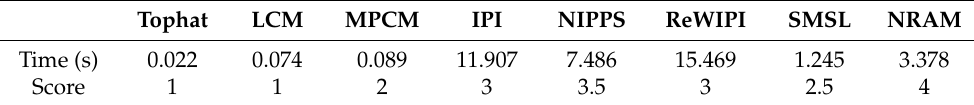
Table 1. The computation time and performance of eight representative methods.